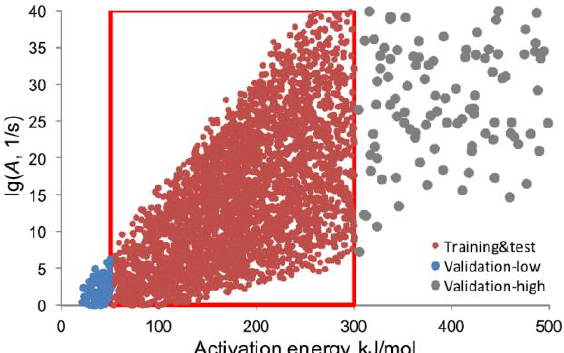
Figure 11. The plot populated with the (preexponential factor, activation energy) pairs used for training and testing of ANNs (red points), and validation of the results (gray and blue points) [21]. Reprinted with permission from Elsevier.